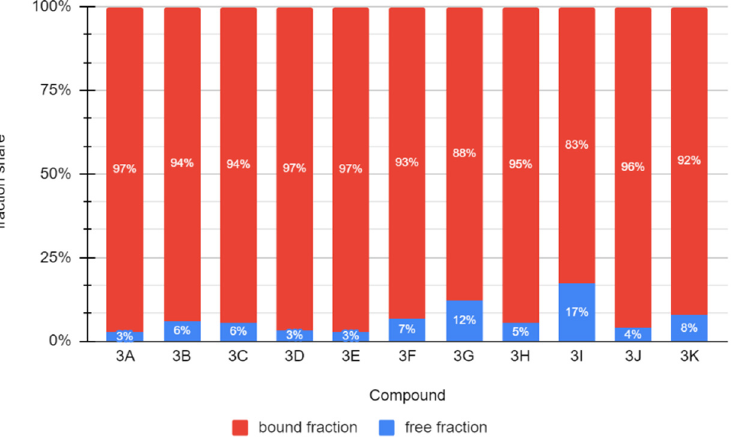
Figure 12. Share of the free fraction of the tested compounds and bound to albumin (for the concentration of albumin in the blood of 44 mg/mL (660 µ M)).